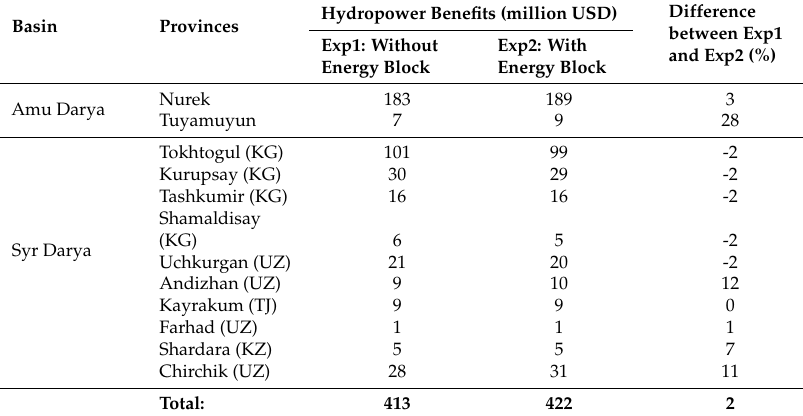
Table 4. Optimal levels of hydropower production benefits (million USD) without (Experiment 1) and with (Experiment 2) considering the energy production and consumption